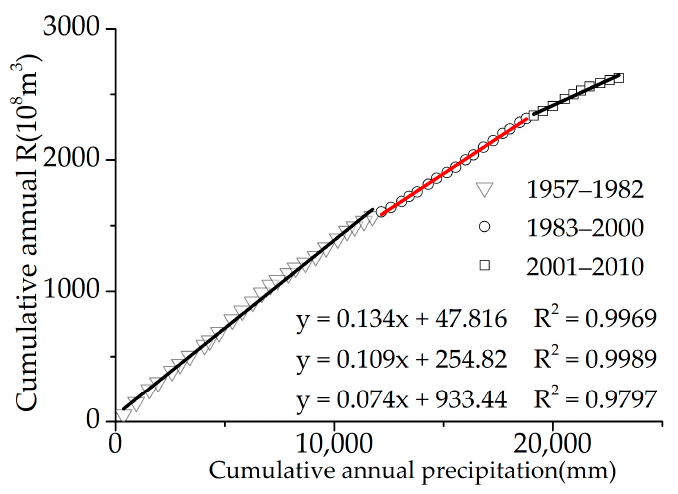
Figure 3. Precipitation–streamflow double cumulative curve for change-point detection in Tou-long region of YRB (1957–2010).